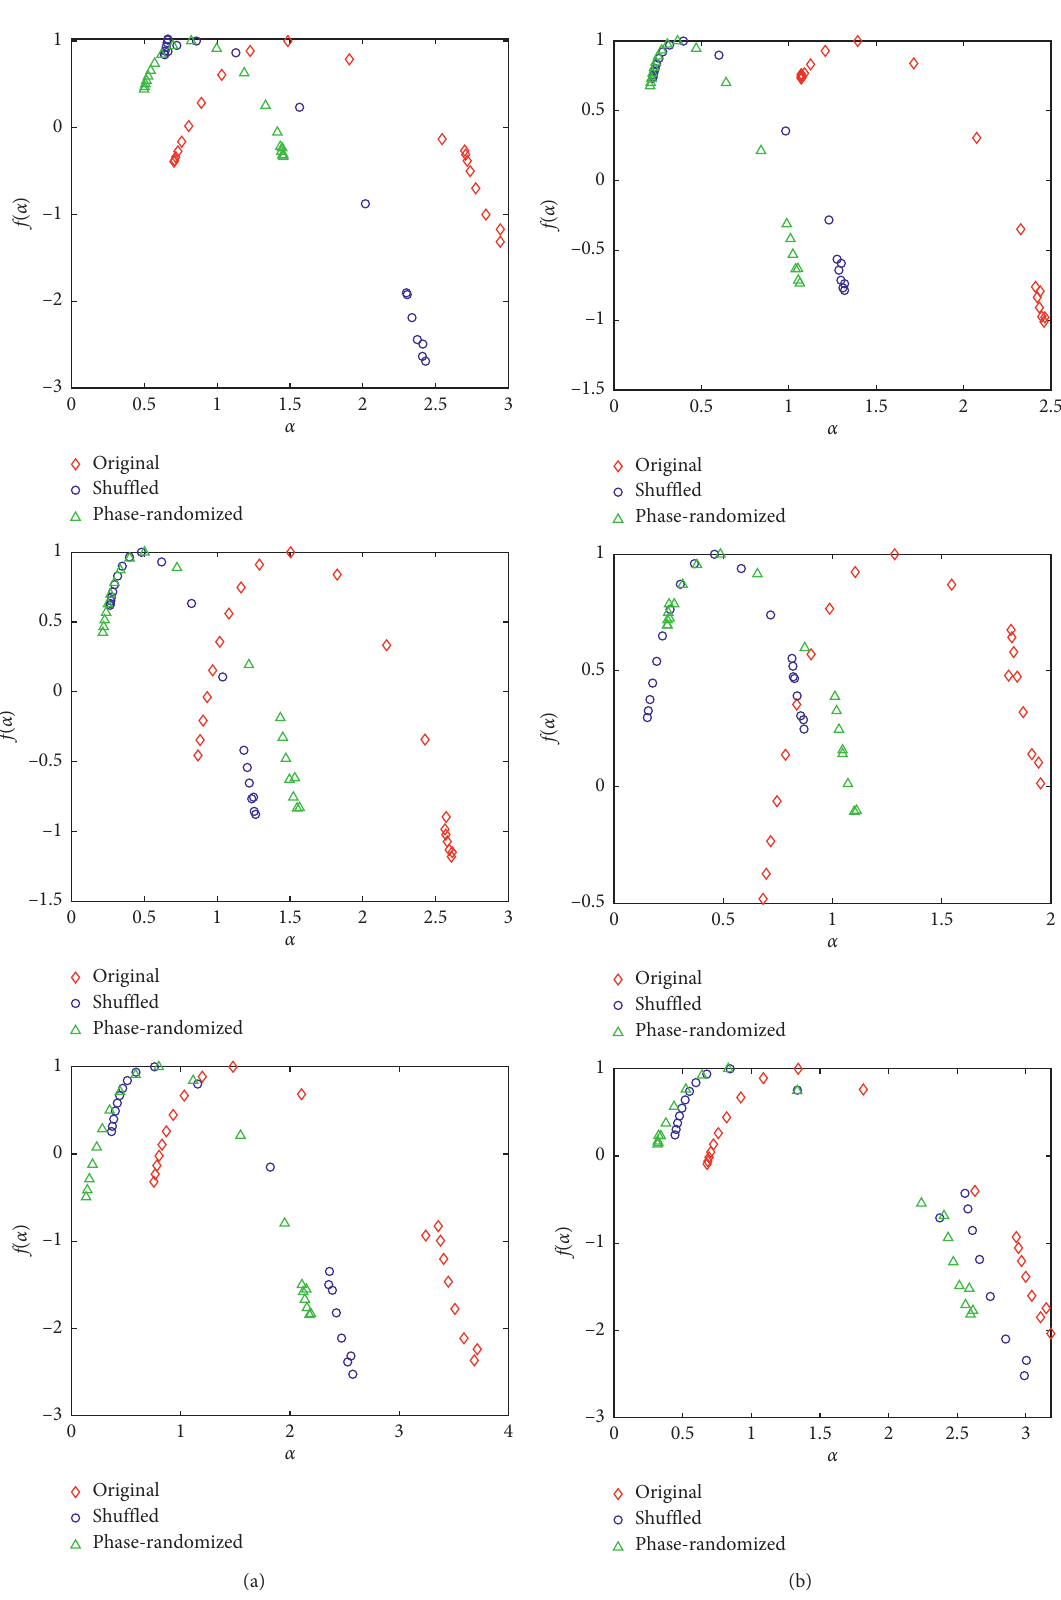
Figure 14: Holder exponent (a) before law and (b) after law. From top to bottom are Seoul, Busan, and